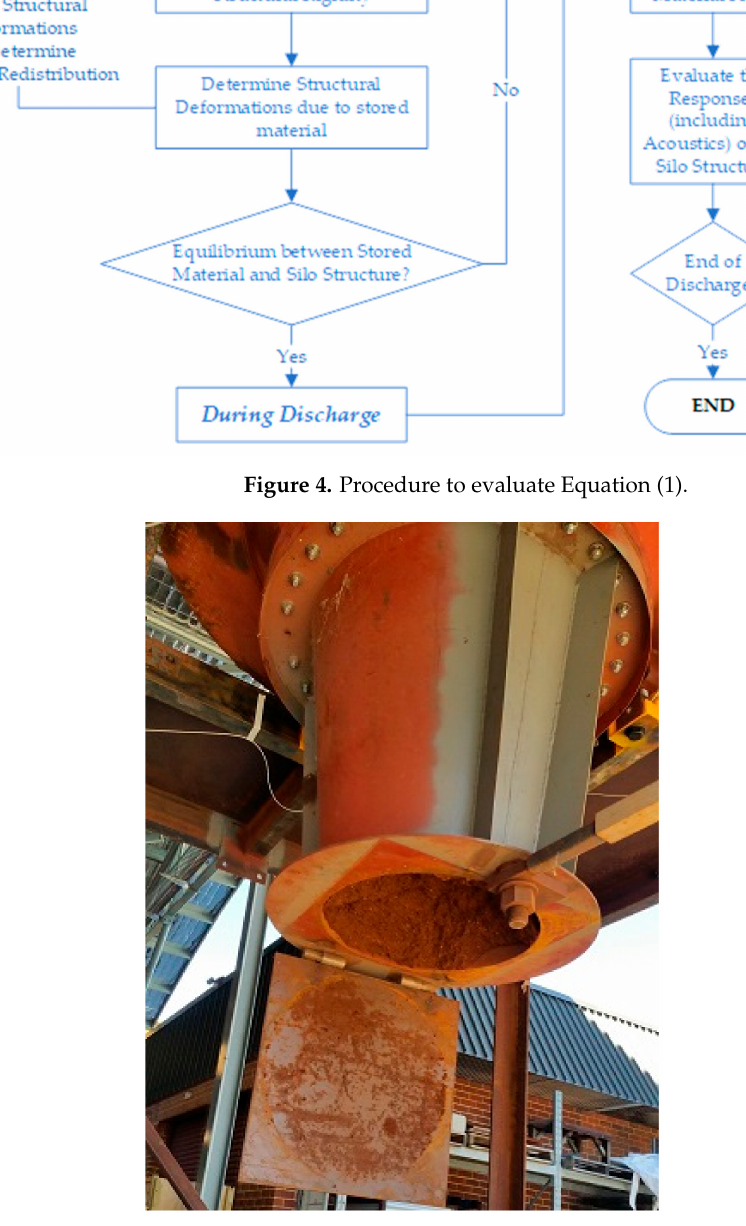
Figure 5. Blocked